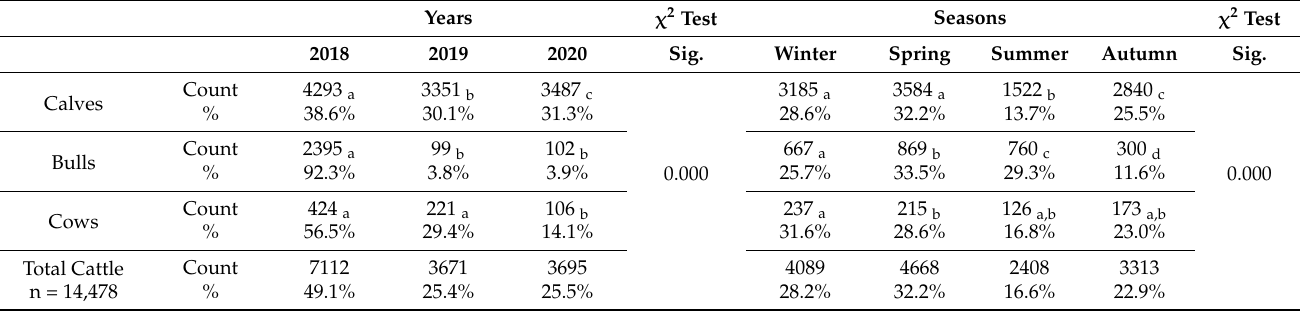
Figure 2. Monthly number of slaughtered cattle during 2018, 2019 and 2020. Table 1. Frequency of cattle slaughtering according to the year and season.